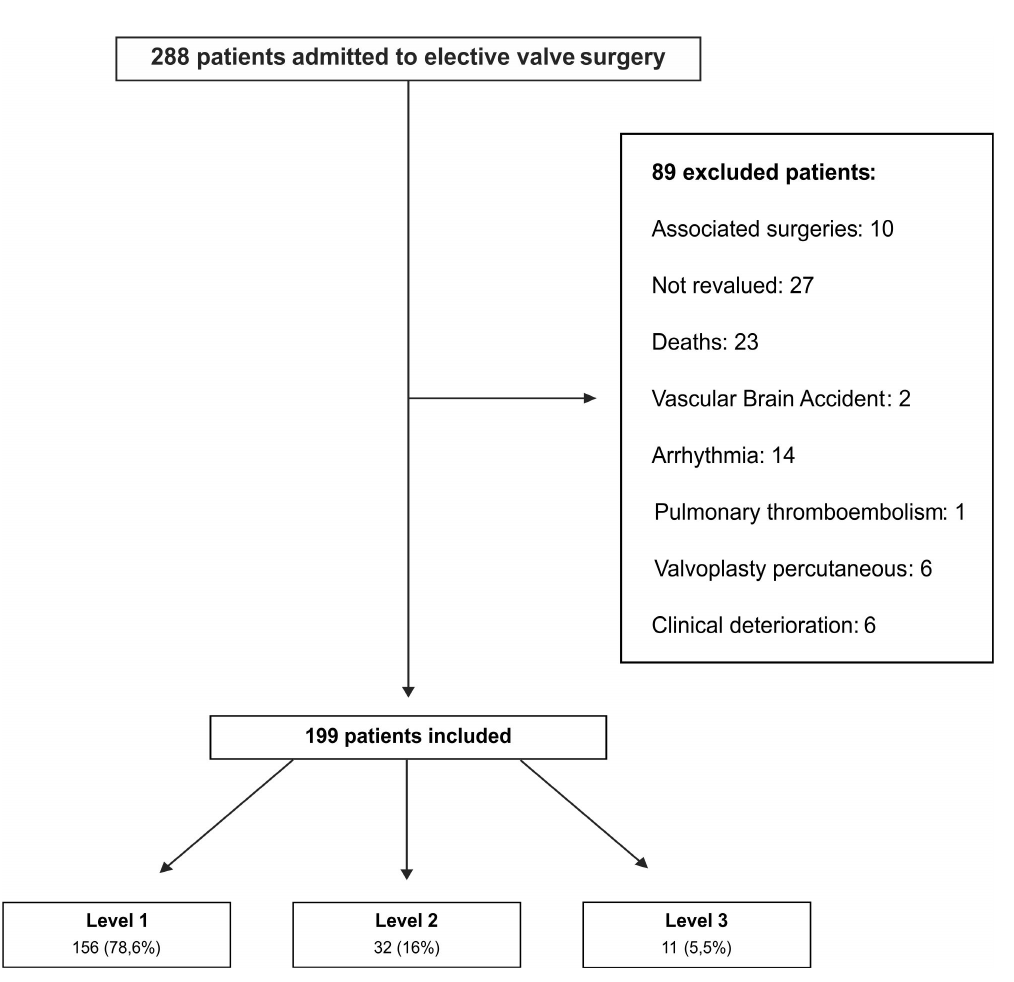
Fig. 1 - The flowchart of patients in the study protocol.